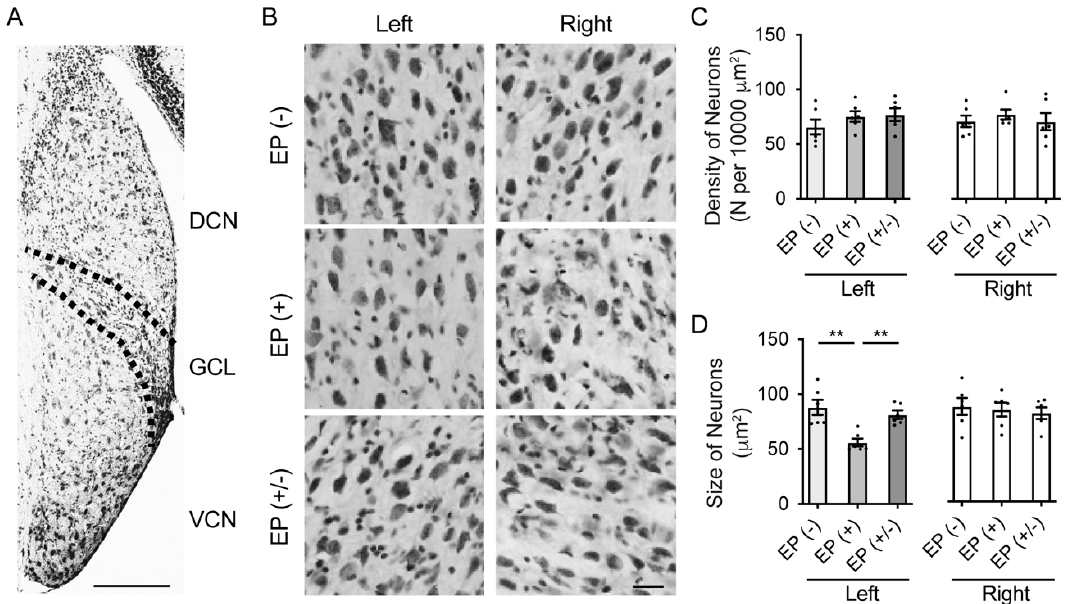
Figure 4. Stereological analysis in the VCN and quantitative analyses of cell density and size. ( A ) Representative images of low magnification stained with cresyl violet show the area of the DCN, GCN, and VCN in the EP(-) mice. Scale bar indicates 200 μ m. ( B ) Representative images of the VCN in high magnification showed the characteristics of VCN cells in each group. Scale bar indicates 50 μ m. ( C ) Quantitative analysis showed that the density of neurons was not significantly different among groups in both ears. ( D ) Quantitative analysis showed that the neuron size in the VCN for the right ear was not significantly different among groups; however, neuron size was significantly smaller in the left ear of the EP(+) mice than in the EP(-) and EP(+/-) mice. EP, earplug; DCN, dorsal cochlear nucleus; GCL, granule cell lamina; VCN, ventral cochlear nucleus. **, p < 0.01.